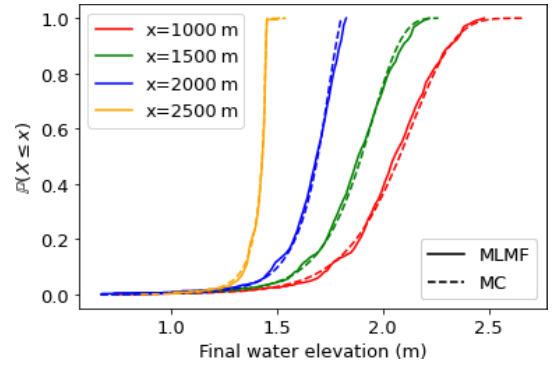
Figure 11. CDFs generated from MLMF outputs using the modified inverse transform sampling method (Eq. 17) compared with those generated using Monte Carlo (MC) outputs for the non-breaking wave test